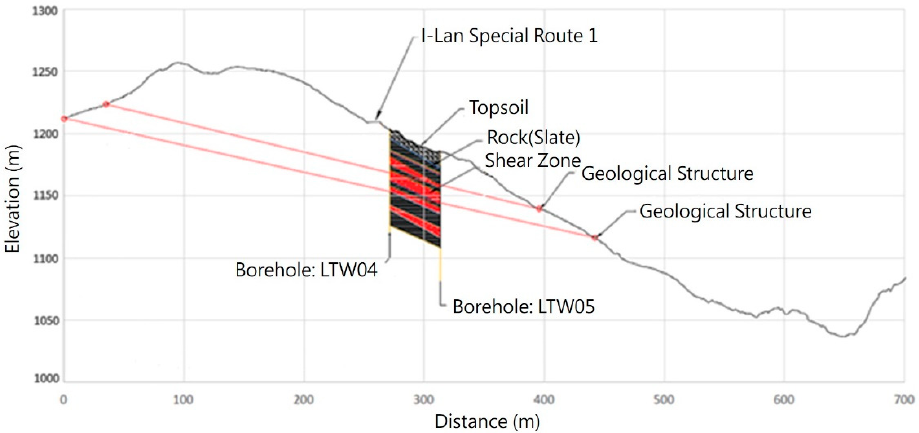
Figure 14. The slope profile along profile X-X’ based on DTM5 before the event, showing the borehole loggings of LTW04 and LTW05, with black color indicating rock material (slate), and the red color indicating shear zone material. A shear zone bounded by the two geological structure surfaces was assumed and projected on the profile by red lines. Table 1. Parameters of material property of each ground layer used in the numerical analysis.